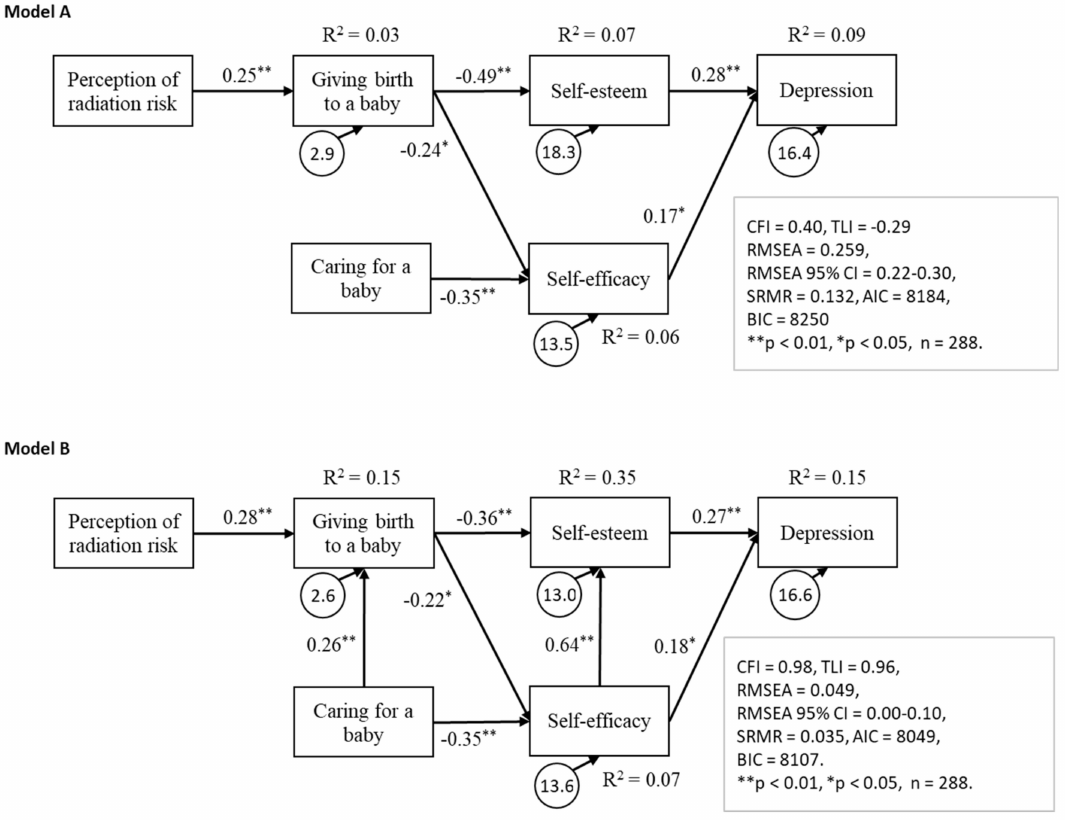
Figure 1. The pathway model for depressive